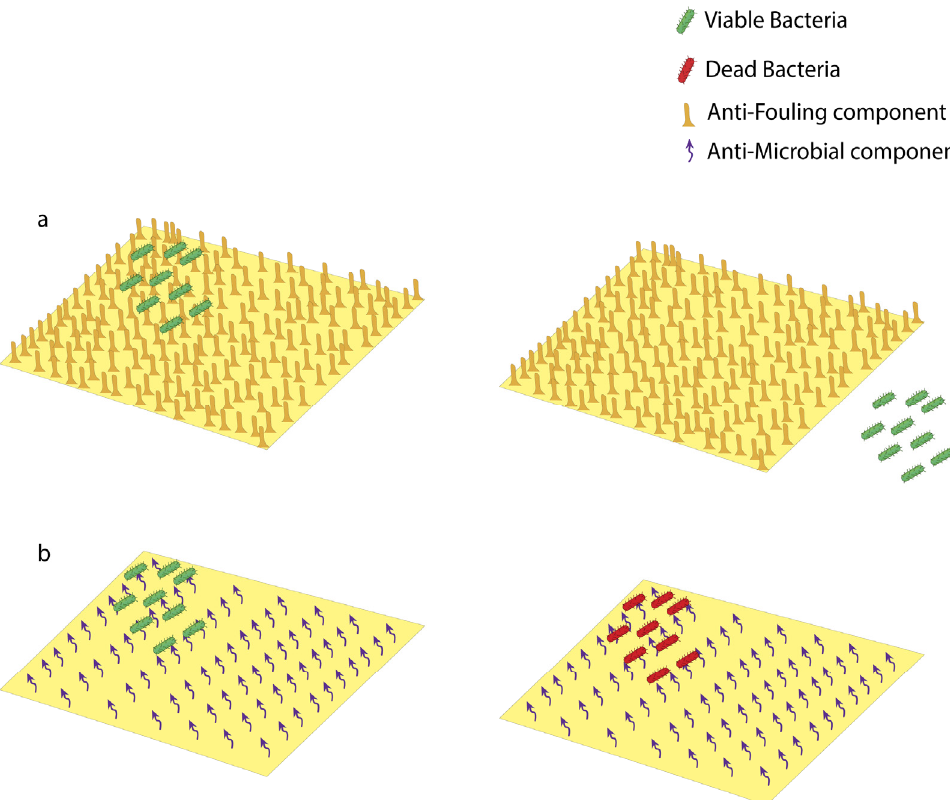
Figure 3. Antifouling and antimicrobial surfaces. ( a ) Antifouling surface to block the attachment of pathogens; on the left bacteria approach the surface, on the right the anti ‐ fouling surface blocks attachment. ( b ) Anti ‐ microbial surface to kill pathogens upon contact; on the left bacteria approach the surface, on the right interaction with the anti ‐ microbial surface is lethal.